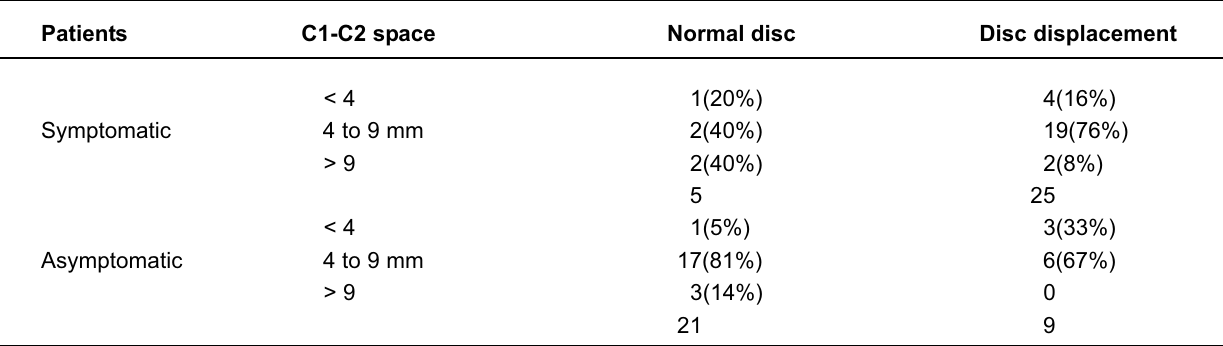
Fisher’s exact test (p>0.05); symptomatic (p=0.08) and asymptomatic (p=0.09).